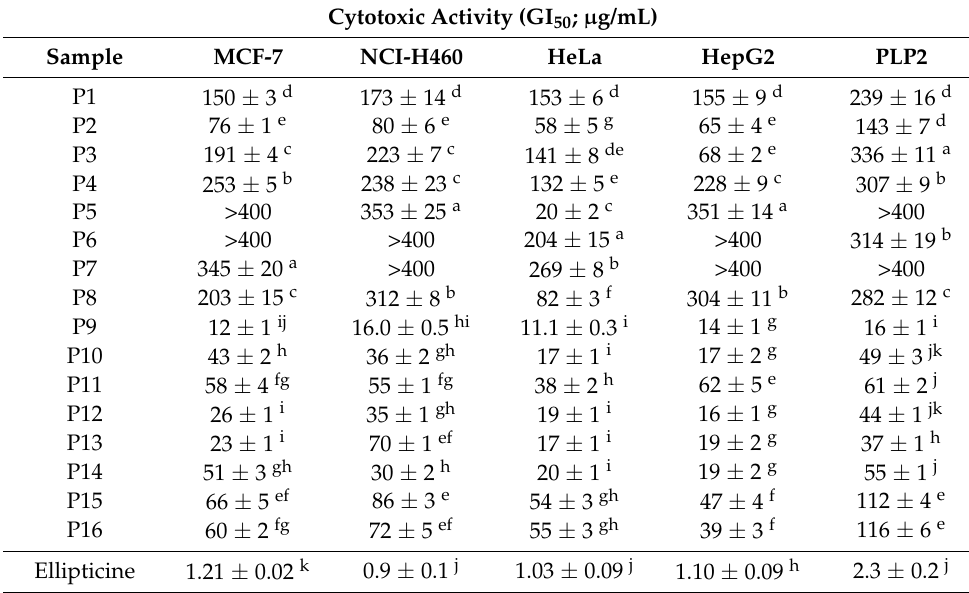
Table 5. Cytotoxic activity of the hydroethanolic extracts of cardoon